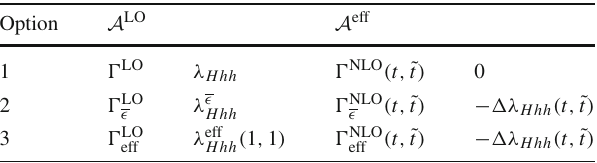
Table 1 Different width calculations employed in our numerical anal- ysis Option